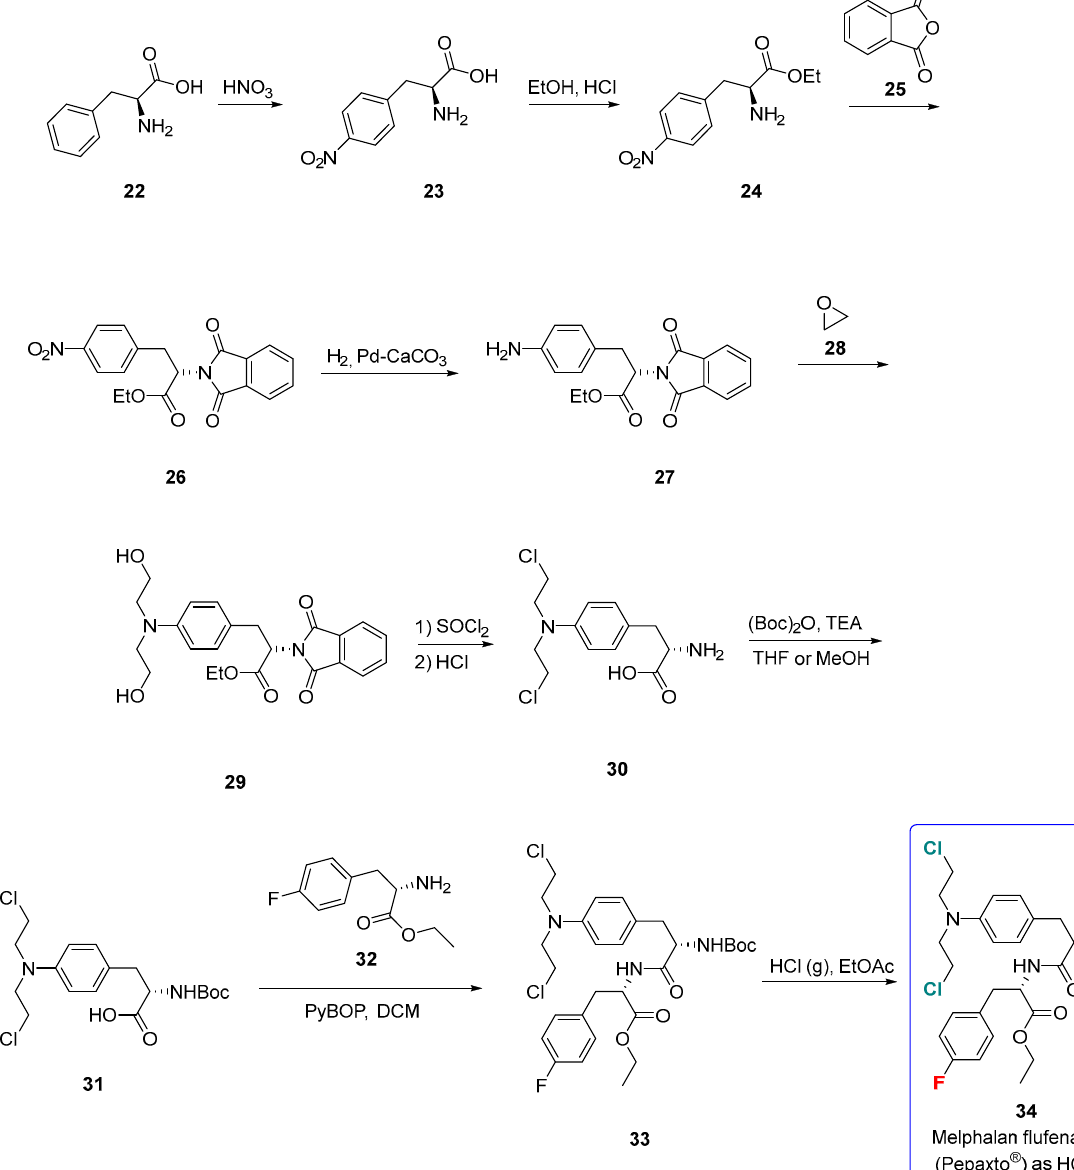
Lastly, the removal of the BOC-protecting group by adding gaseous HCl yielded melflufen hydrochloride ( 34 ). A multi-kilogram production route (Scheme S2) for melflufen in high purity has been recently disclosed